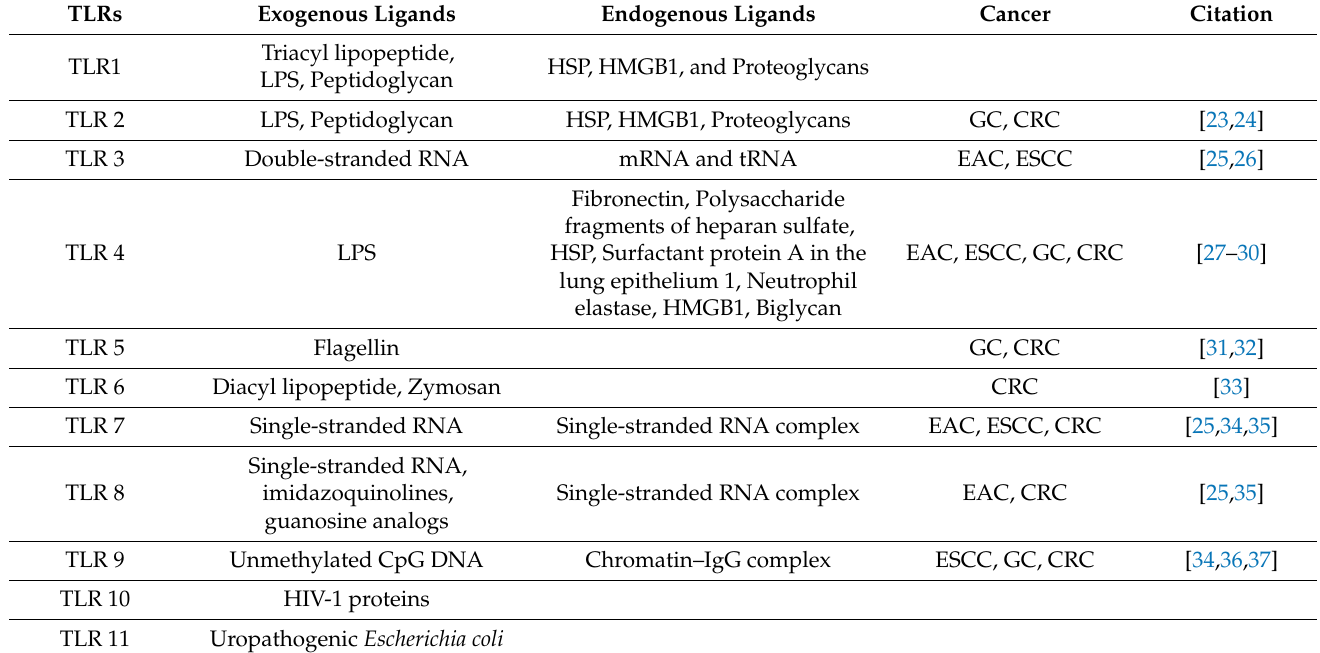
Table 1. Exogenous and endogenous ligands of Toll-like receptors (TLR) and main gastrointestinal cancers implicated in